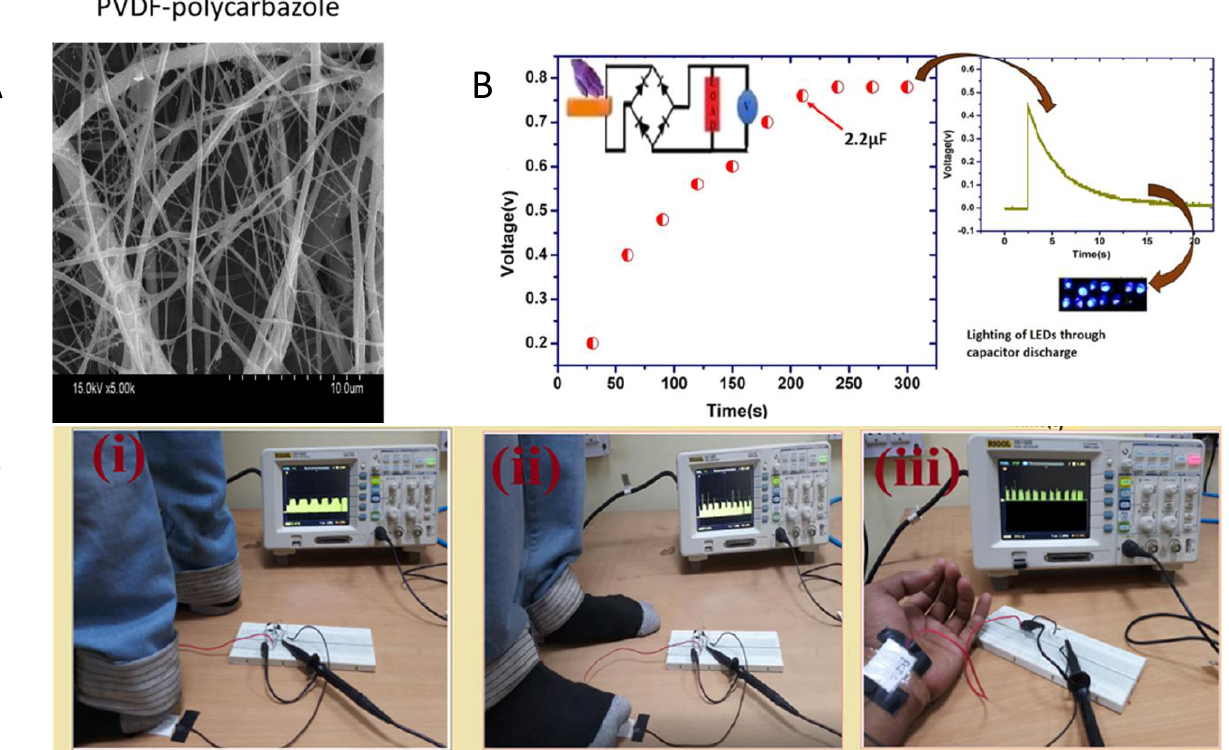
Figure 24. Energy-harvesting device constructed from PVDF – PCZ [235]: ( A ) SEM image of PVDF – PCZ nanofibers; ( B ) voltage measurements of the PVDF – PCZ nanocomposite showing the charging of a capacitor, and subsequent illumination of five LEDs after discharging; ( C ) types of human motion that generated voltage in the nanocomposite: ( i ) heel movement, ( ii ) toe movement, and ( iii ) wrist bending. Reprinted with permission from [235]. Copyright 2021, American Chemical Society.